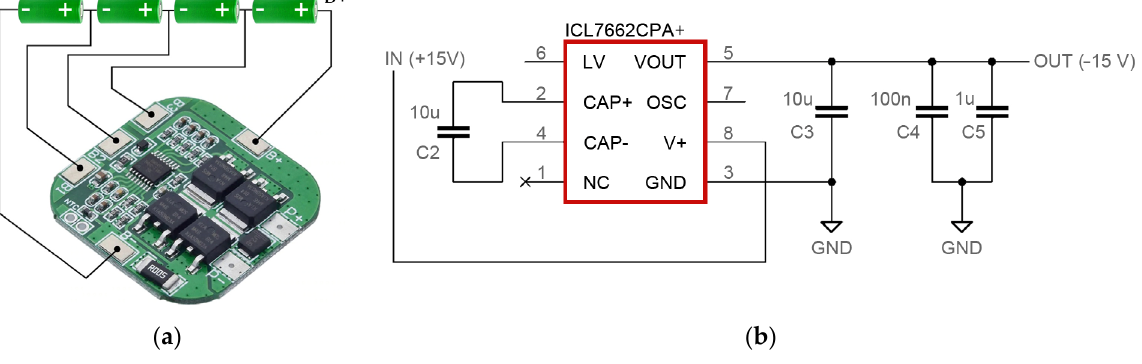
Figure 7. Components of the power supply system: ( a ) battery management system BMS 4S with the package of four series-connected lithium-ion cells US18650VTC5A; ( b ) electronic circuit diagram of the voltage converter